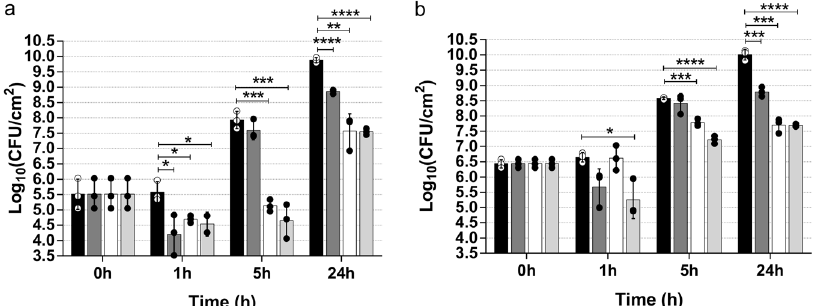
Fig. 6 Antibio fi lm effect of CHAPSH3b, phiIPLA-RODI or a combination of both on premature bio fi lms in an ex vivo model of intact and wounded skin. A porcine ex vivo model of intact skin ( a ) and skin wound ( b ) infection ( n = 3) infected with 3-h-old bio fi lms of S. aureus V329 (~10 5 CFU/g skin) was treated with either CHAPSH3b (8 µM), phiIPLA-RODI (MOI of 588) or a combination of both (8 µM and MOI of 588, respectively). Bars represent the means and standard deviations of three independent experiments. Bars with an asterisk are statistically different ( p < 0.05) from the untreated control according to the Student ’ s t -test using the Holm-Sidak